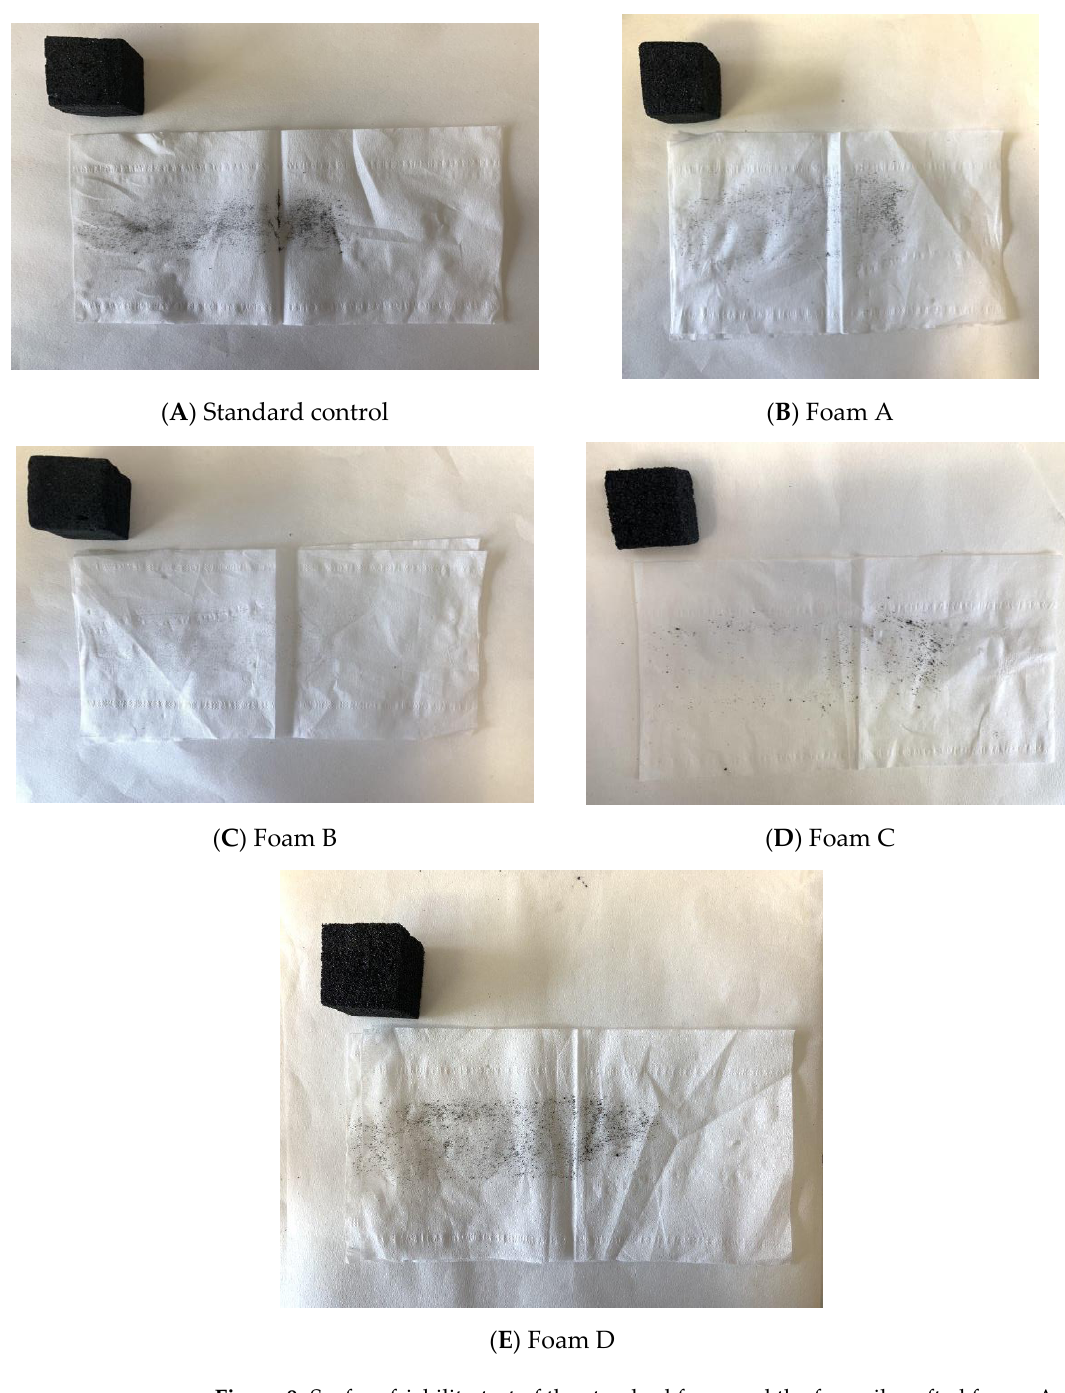
Figure 9. Surface friability test of the standard foam and the four oil-grafted foams A, B, C, and D.